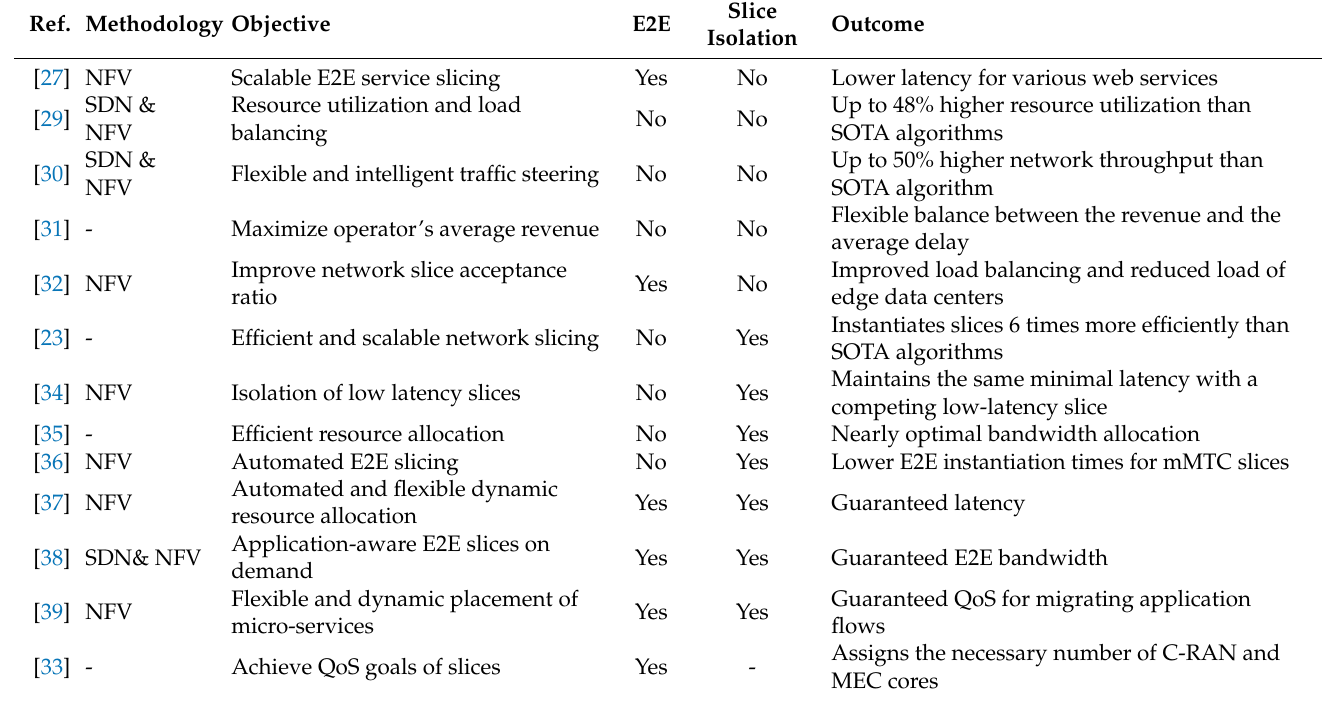
Table 2. Overview of edge-enabled slicing studies mentioned in Section 2.